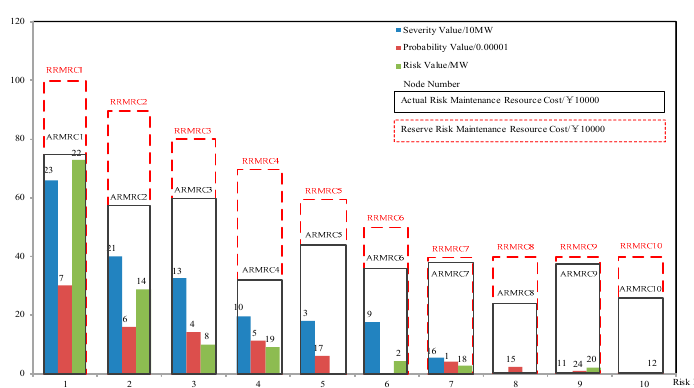
Figure 8. Diagram of the risk rating based on SPRV and RRMRC in the RTS-79 system. Figure 8, the red dotted frame indicates the reserve risk maintenance resource cost (RRMRC) value in the system for each level of risk rating. The black wireframe indicates the actual risk maintenance resource cost (ARMRC) value of each risk rating level. The nodes included in the black wireframe are the nodes with a risk rating level. The actual risk maintenance resource cost value is equal to the sum of the risk maintenance resource costs of all nodes included in the risk rating level. The blue column indicates the node disconnection severity (NDS) value, the red column indicates the node disconnection probability (NDP) value, and the green column indicates the node disconnection risk valuation (NDRV).